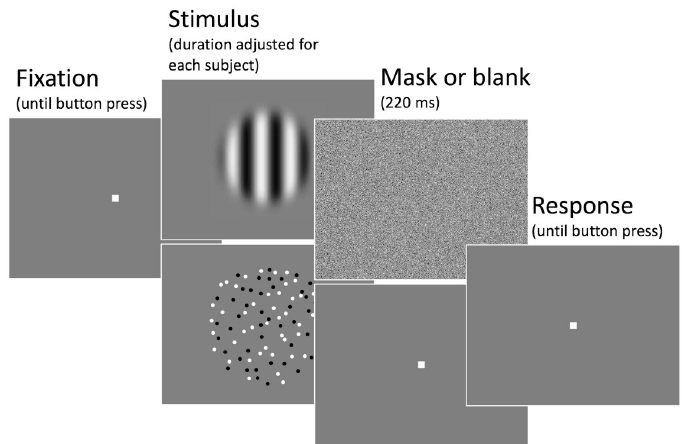
Fig 1. Example trial sequence. Subjects initiated each trial with a button press. Either a drifting grating or a random dot pattern moving to the left or to the right will then be briefly presented for a duration that will be adjusted for each subject individually to ensure a significant but not perfect performance of about 75% for the intermediate stimulus size. After the stimulus, either a white noise mask or a blank screen will be shown for 220 ms. Note that these are cartoons of the actual stimuli and that this figure has been optimized (e.g., in terms the grating’s Gaussian envelope or the RDP’s dot-size and number of dots) to illustrate the sequence of events.